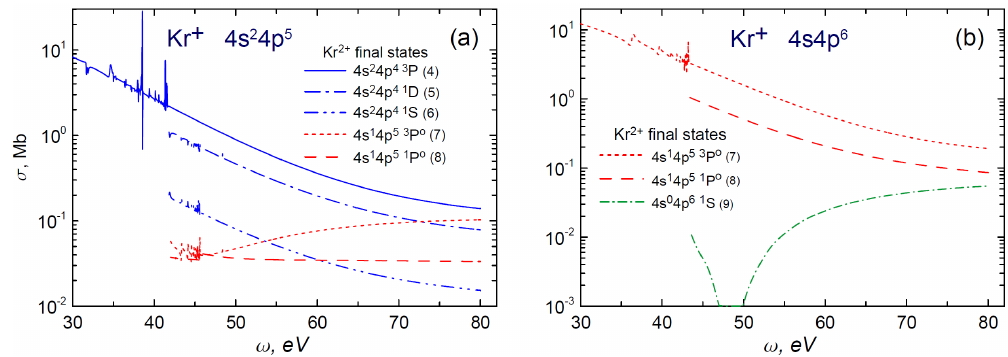
Figure 7. Photoionization cross-sections from the 4 s 2 4 p 5 2 P o ( a ) and 4 s 1 4 p 6 2 S state ( b ) of Kr + . Legends for the curves with the corresponding final Kr 2 + multiplet states and their numbers (in parenthesis) according to Table 1 are presented. The blue lines in ( a ) correspond to ionization of the 4 p electron into different terms of the Kr 2 + 4 s 2 4 p 4 configuration. The green dash-dotted line in ( b ) corresponds to producing of the double-hole state Kr 2 + 4 s 0 4 p 6 . Identical red lines in the both panels show transitions to the same final states from Kr + 4 s 2 4 p 5 (panel ( a )) and Kr + 4 s 4 p 6 (panel ( b )), respectively.